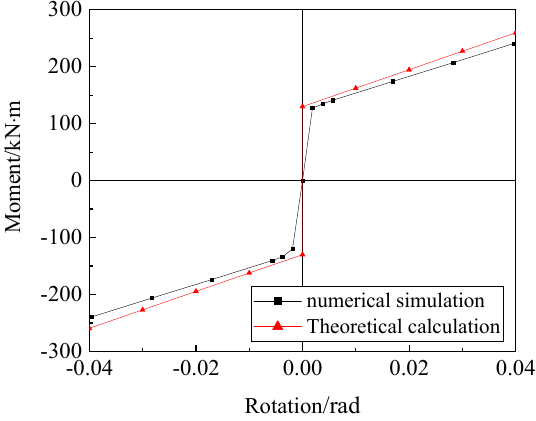
Figure 11. Envelope curves of the joint.